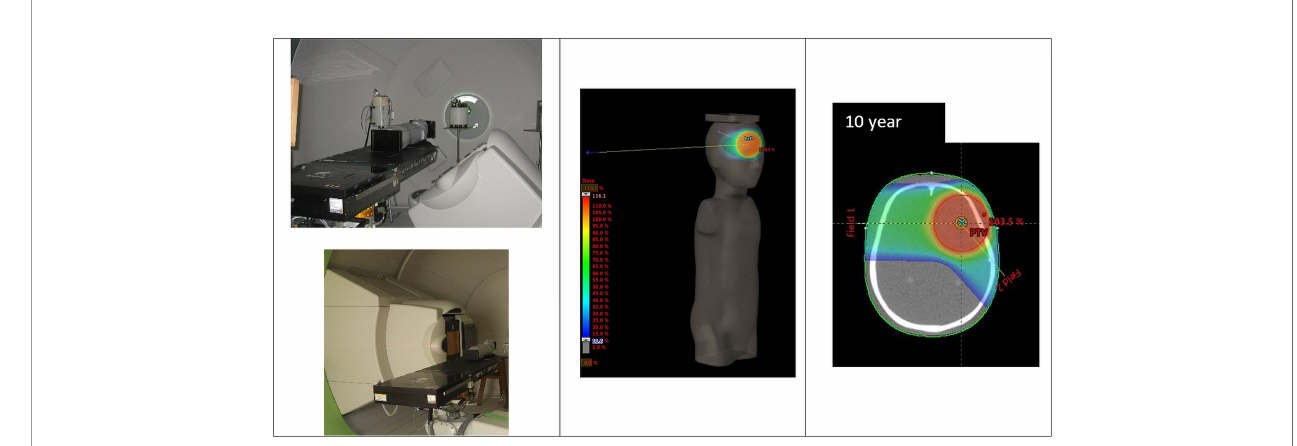
FIGURE 1 | Irradiation setup and tumor location for the IMPT-simulated